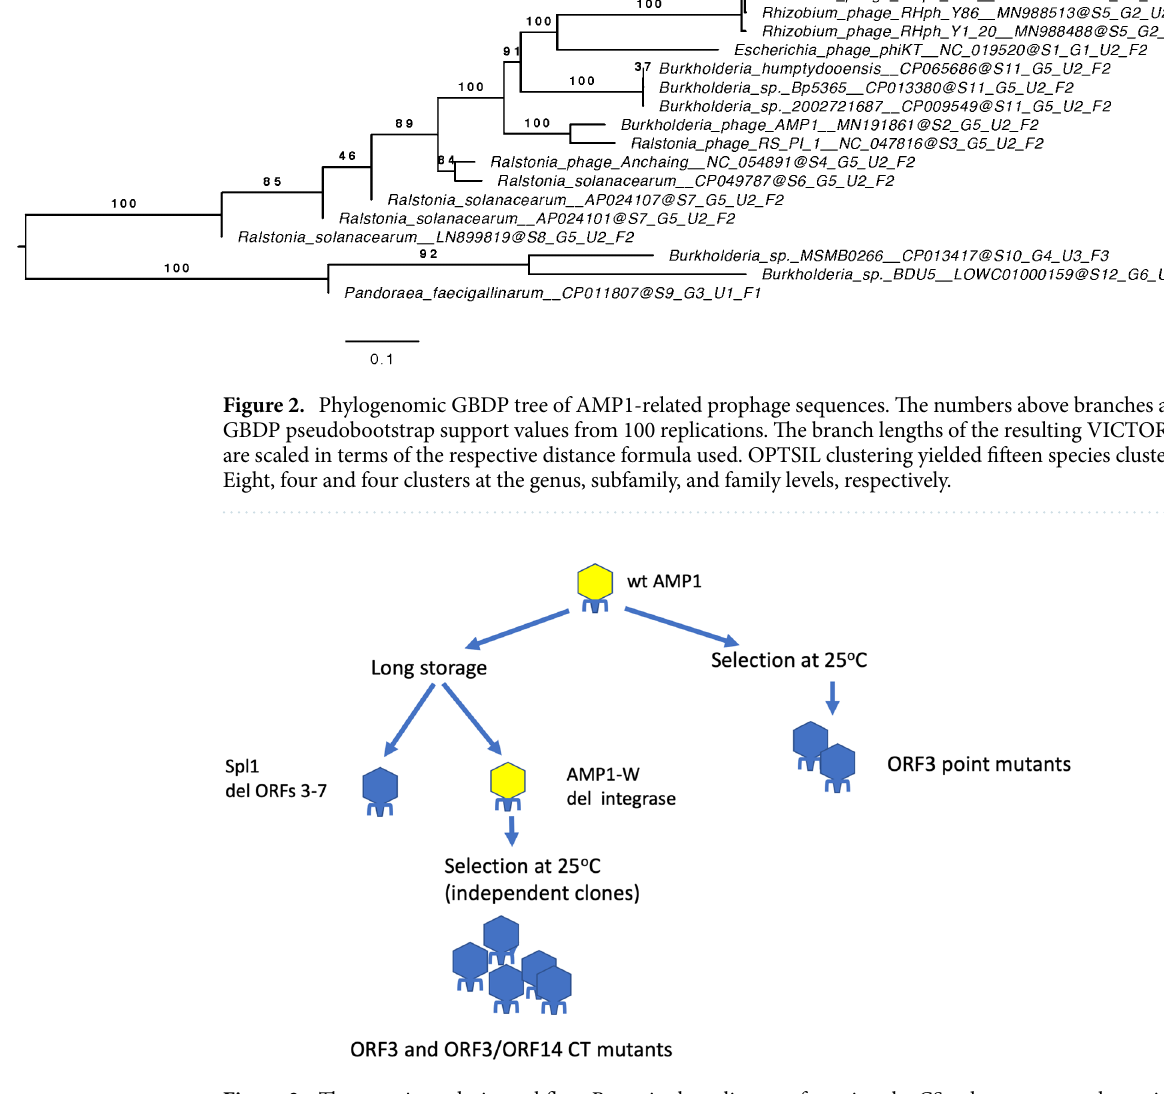
Figure 3. The genetic analysis workflow. Bacteriophage lineages featuring the CSg phenotype are shown in yellow, the cold-tolerant mutants are shown in